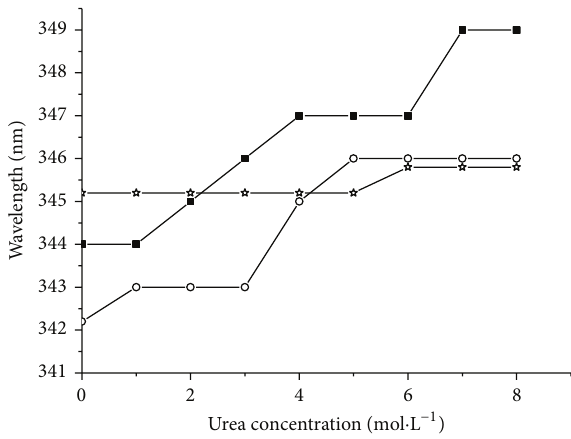
Figure5:Ureadenaturation-emissionwavelengthmaximumversus urea concentration. ◼ is ZNF191(243-368), I is His 6 -ZNF191(243- 368), and f is ZNF191(243-368)-His 8 .